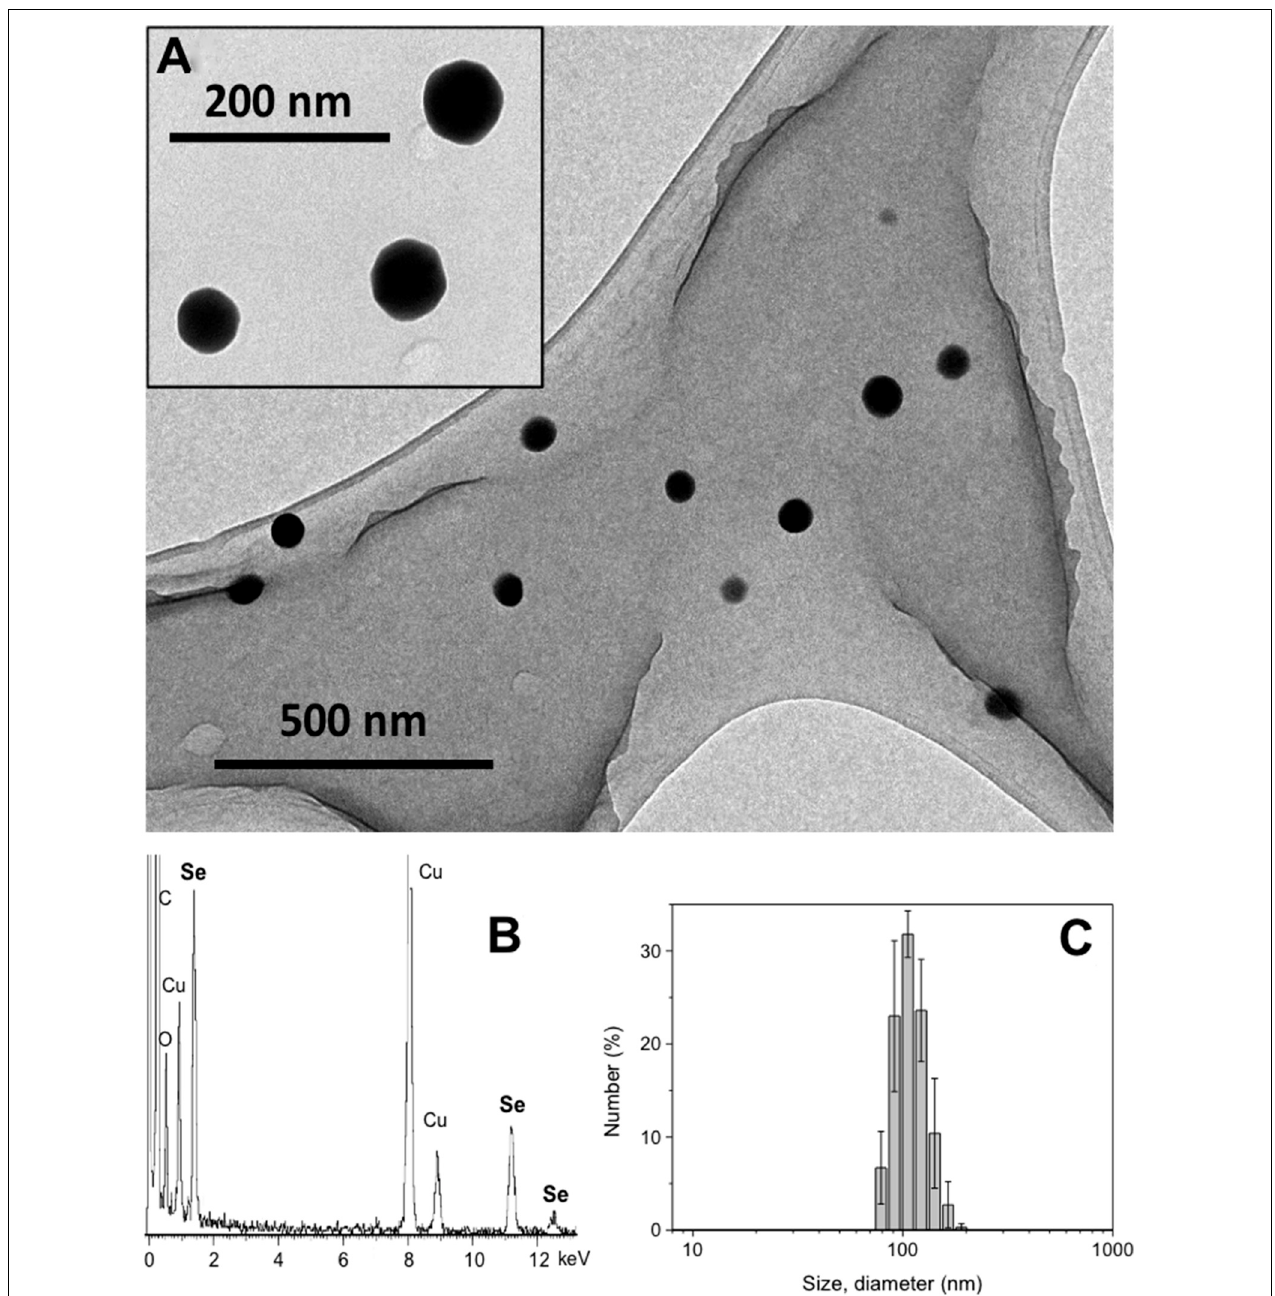
FIGURE 1 | Characterization of the synthesized SeNPs. (A) TEM images of a 200 mg L − 1 suspension of Ch-SeNPs. (B) EDS spectrum of Ch-SeNPs. (C) Hydrodynamic size distribution of the Ch-SeNPs in aqueous colloidal suspension measured by dynamic light